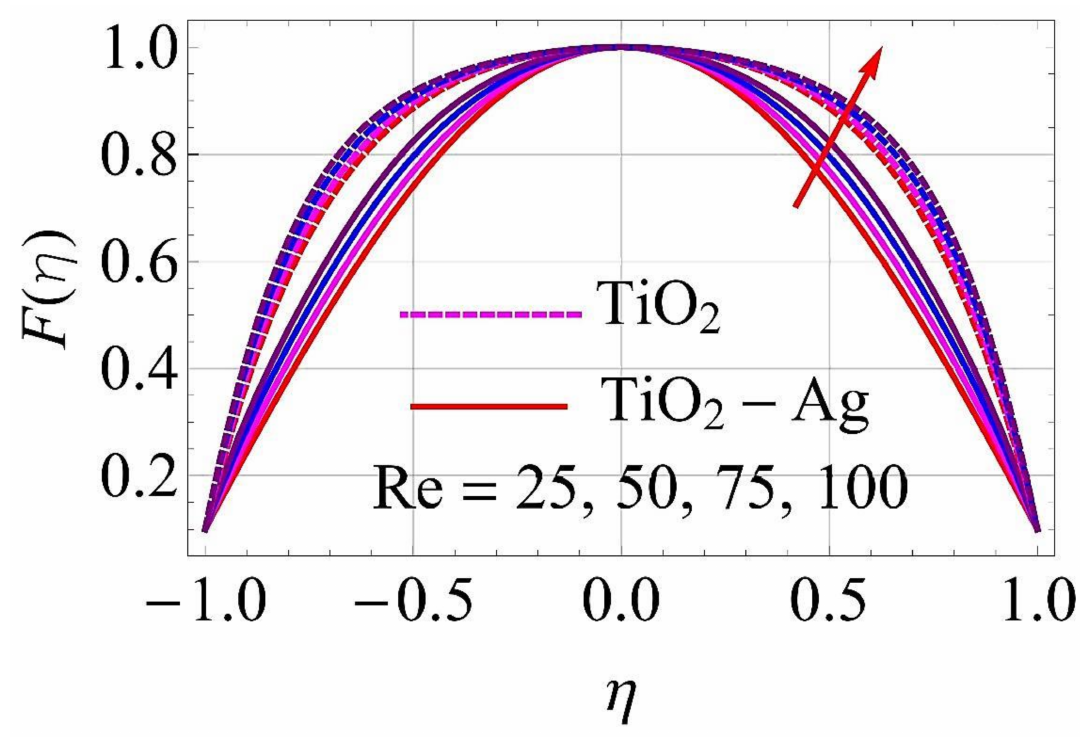
Figure 11. Velocity versus Re with α = − 5 ◦ for converging/stretching circumstances. When φ 1 = φ 2 = 0.01, Rd = 0.4, Ec = Q = Ha = k ∗ = Fr = K 1 = 0.1.